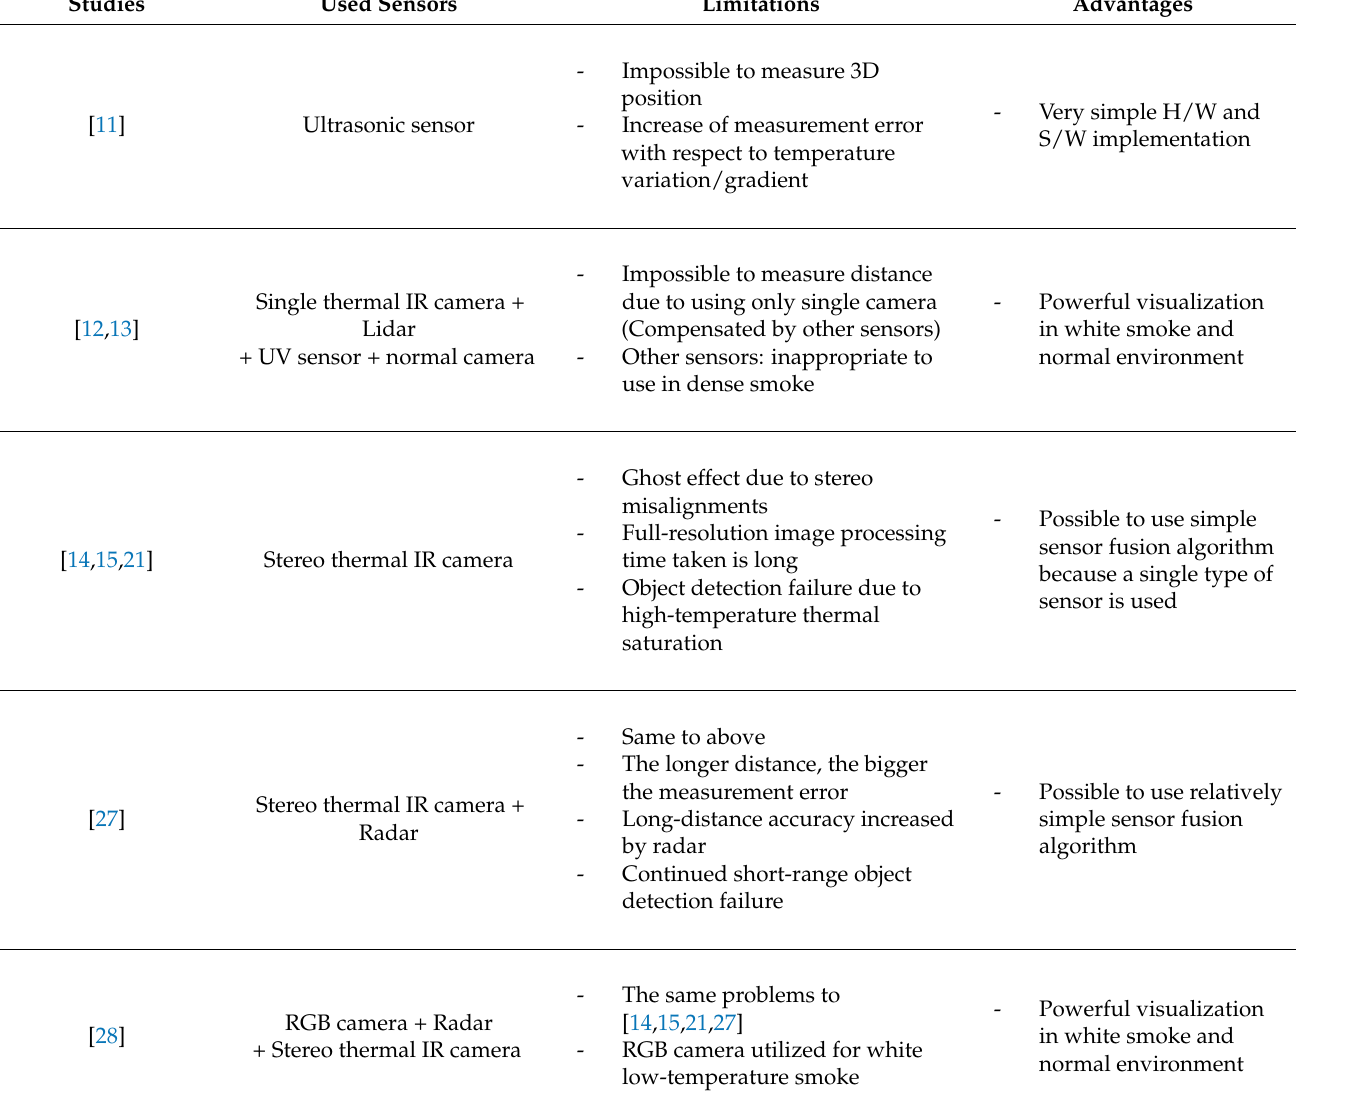
Table 1. Research on detecting objects in dense smoke and its